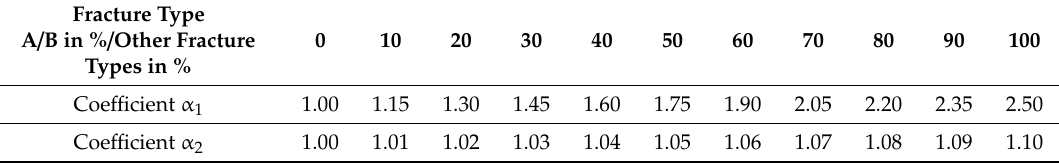
Table 8. Fracture type correction factor (by Momber et al.)